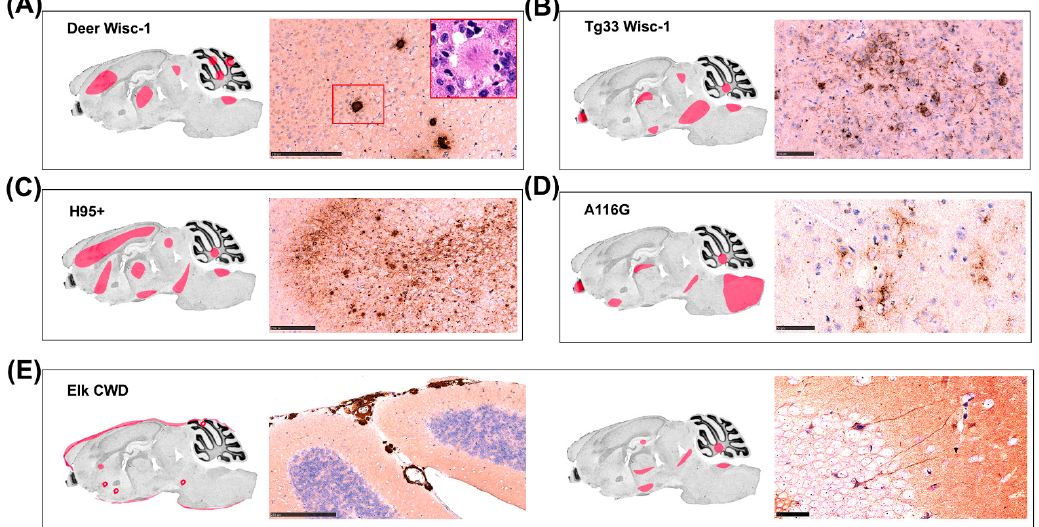
Figure 4. Distribution and variety of neuropathological changes observed in tgBeaver mice inoculated with several CWD strains. Regions with extensive neuropathological change are highlighted in pink. ( A ) PrPd plaques were observed by immunohistochemical staining in mice inoculated with deer Wisc-1. Inset picture (hematoxylin & eosin staining) shows the characteristic morphology of a florid plaque, surrounded by a halo of spongiform degeneration. ( B ) Intraneuronal PrPd aggregates were abundant in mice inoculated with tg33 Wisc-1 prions. ( C ) Abundant and widely distributed plaques and granular deposits were observed in one mouse inoculated with H95+ strain. ( D ) Stellate PrPd deposits, associated with reactive glia, were detected in mice challenged with the A166G strain. ( E ) Subpial and perivascular deposits were observed in one mouse inoculated with elk CWD2 strain ( left ), whereas other mice presented with intraneuronal and axonal deposits ( right ). Immunohistochemical staining for PrP was performed using mAB Bar224 1:1000. Scale bar is 200 µ m for panels ( A , E ) ( left ) and 50 µ m for panels ( B – E ) ( right